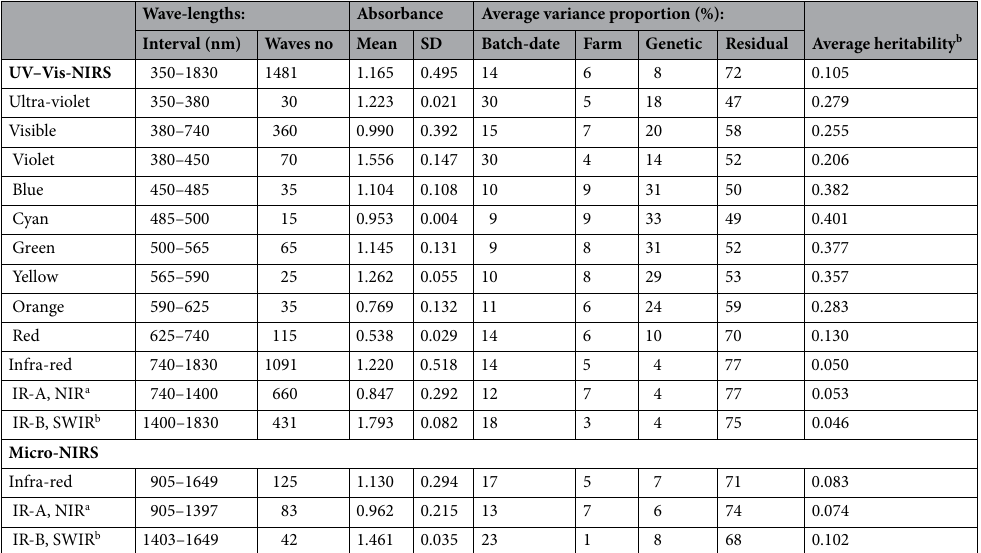
Table 1. Descriptive statistics and summary of major results according different spectral intervals of UV– Vis-NIRS and Micro-NIRS. a Infra-red A or near-infrared (narrow sense); b Infra-red B or short-wavelength infrared. The intra-herd-batch heritability is different for each wavelength (please see Fig. 4) and the ranges of standard error were 0.035–0.088 for UV–Vis-NIRS and 0.026–0.067 for